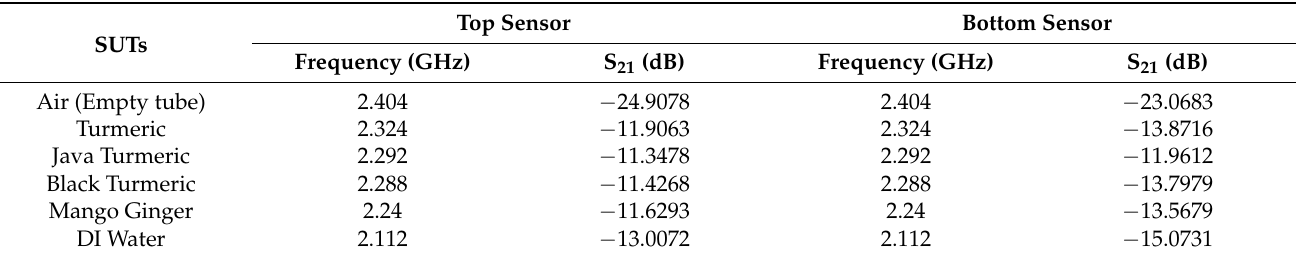
Table 5. Comparative measurement results of semi-solid channel location (PP tube) for top and bottom triple-rings CSRR sensor.